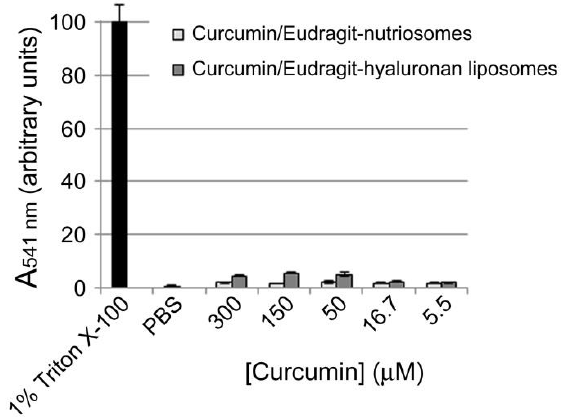
Figure 4. Hemolytic activity of rehydrated curcumin-incorporating Eudragit-nutriosomes and Eudragit-hyaluronan liposomes. The 300 µM curcumin sample contained 2.3 or 3.1 mg/mL of Eudragit-hyaluronan liposomes or Eudragit-nutriosomes, respectively.